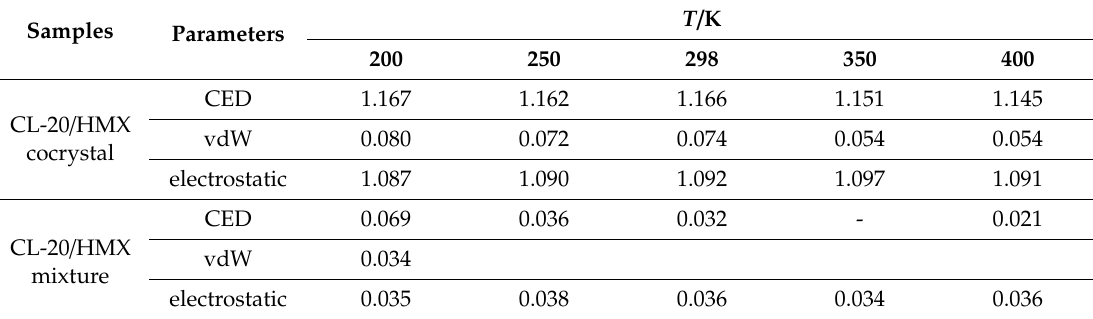
Table4. CEDofCL-20 / HMXcocrystalandmixturesystemsatdi ff erenttemperatures[2], withpermission from Han Neng Cai Liao,